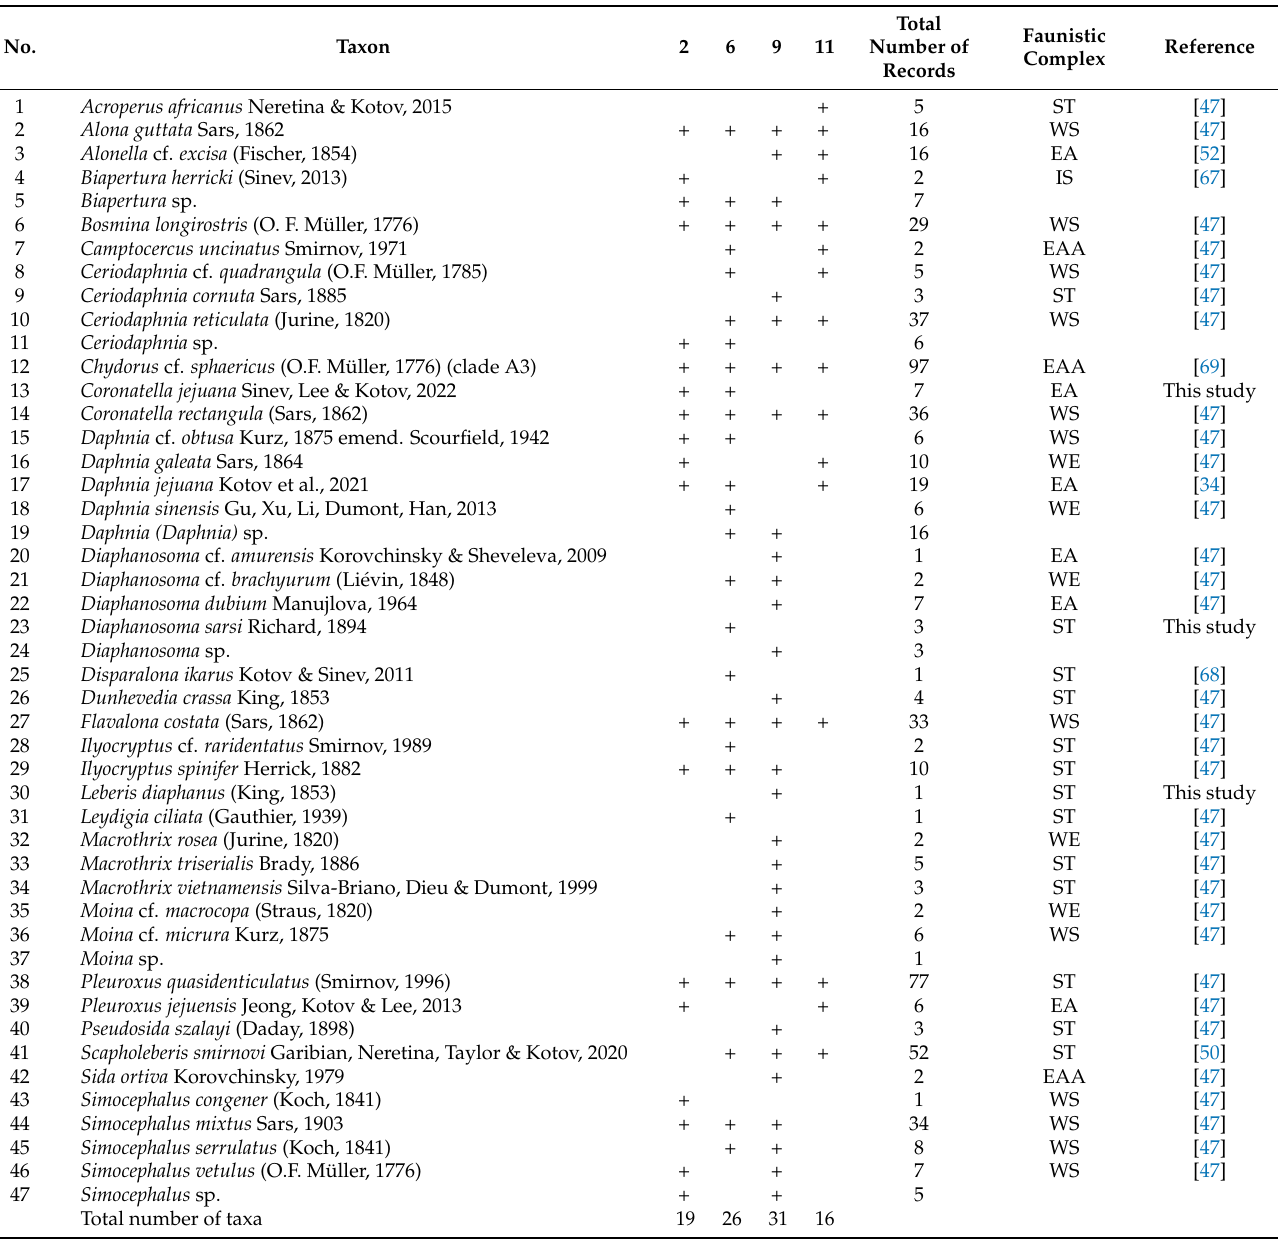
Table 1. Species found in the continental water bodies in Jeju Island during four seasons (month number is marked by a Roman letter: 2—February, 6—June, 9—September, 11—November. See abbreviations for faunistic complexes in the